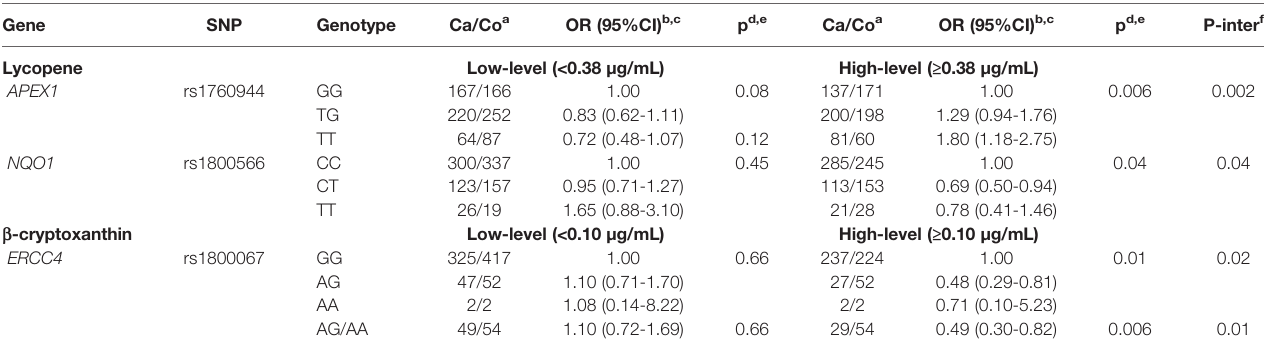
TABLE 3 | Associations of SNPs with prostate cancer risk strati fi ed by serum antioxidants in PCPT placebo arm. Gene SNP